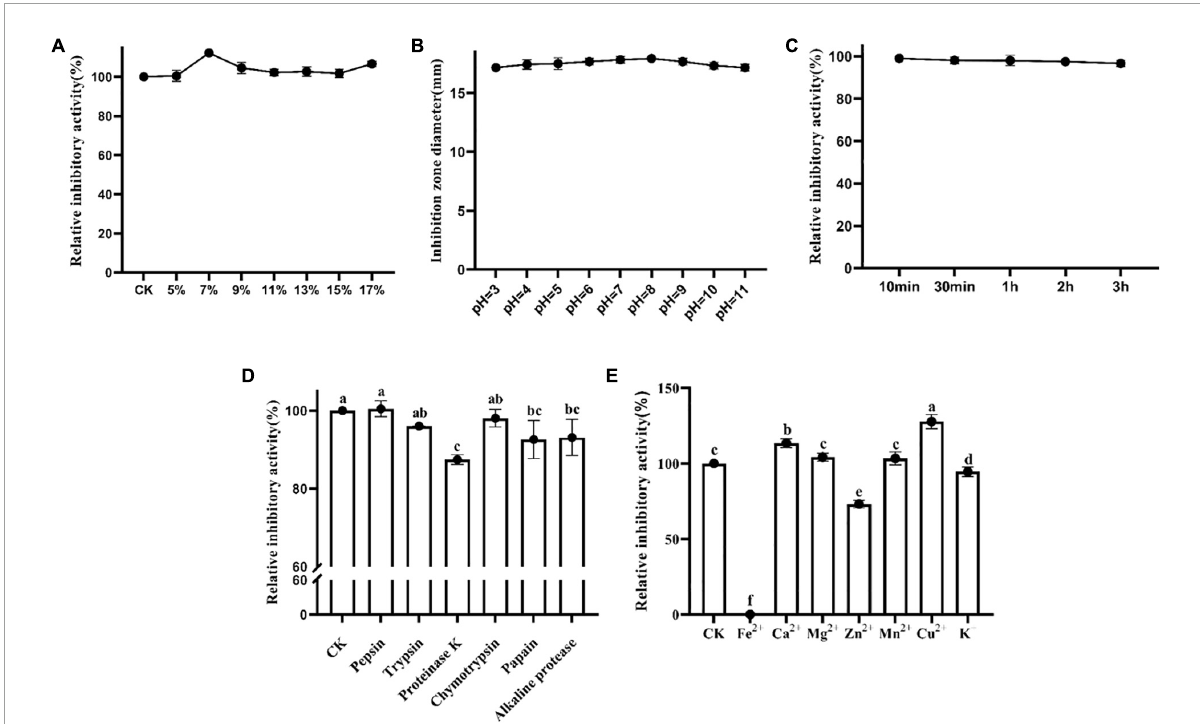
FIGURE3 Sensitivity of Lcn972. (A) Effect of NaCl concentration on the antibacterial activity of Lcn972; (B) effect of pH on the antibacterial activity of Lcn972; (C) sensitivity of Lcn972 to UV; (D) sensitivity of Lcn972 to proteases; (E) sensitivity of Lcn972 to metal ions. Letters on the graph denote statistically significant differences (ANOVA, P <